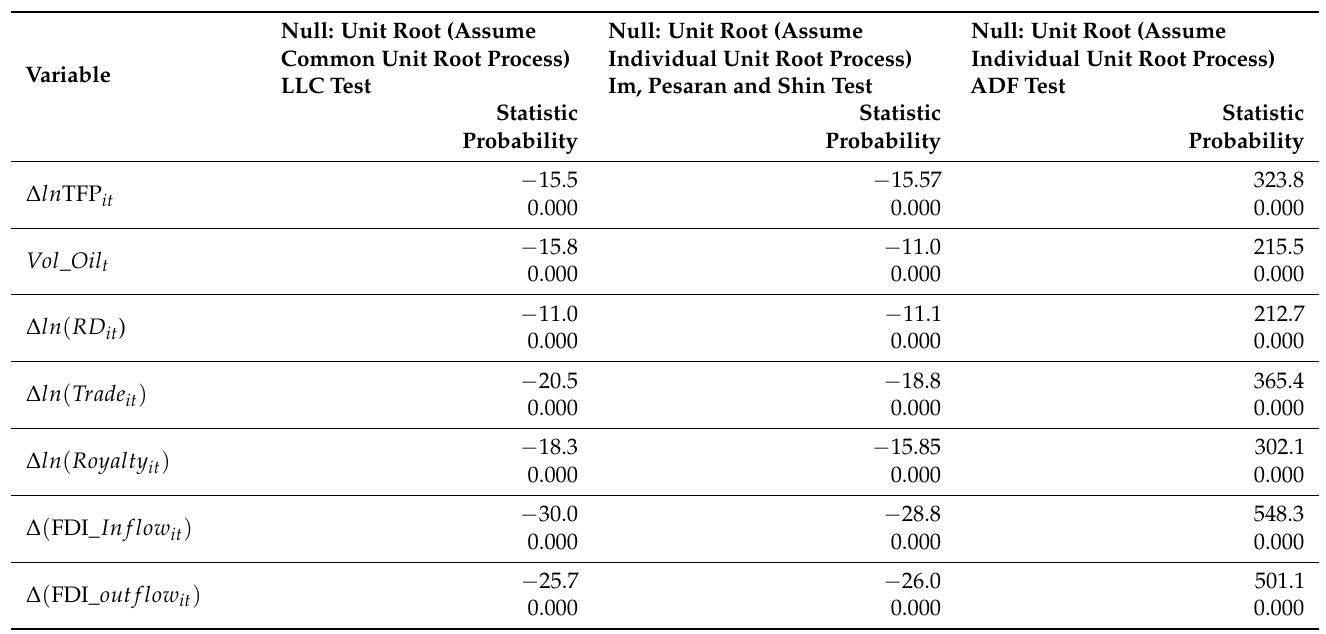
Table 2. Unit root